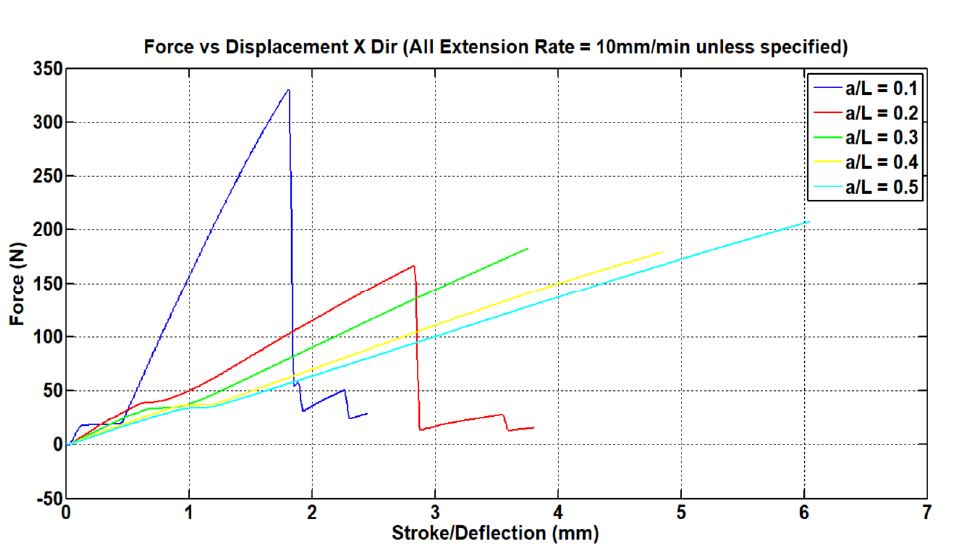
Figure 8. Force vs. displacement plot for loading in the x-direction.